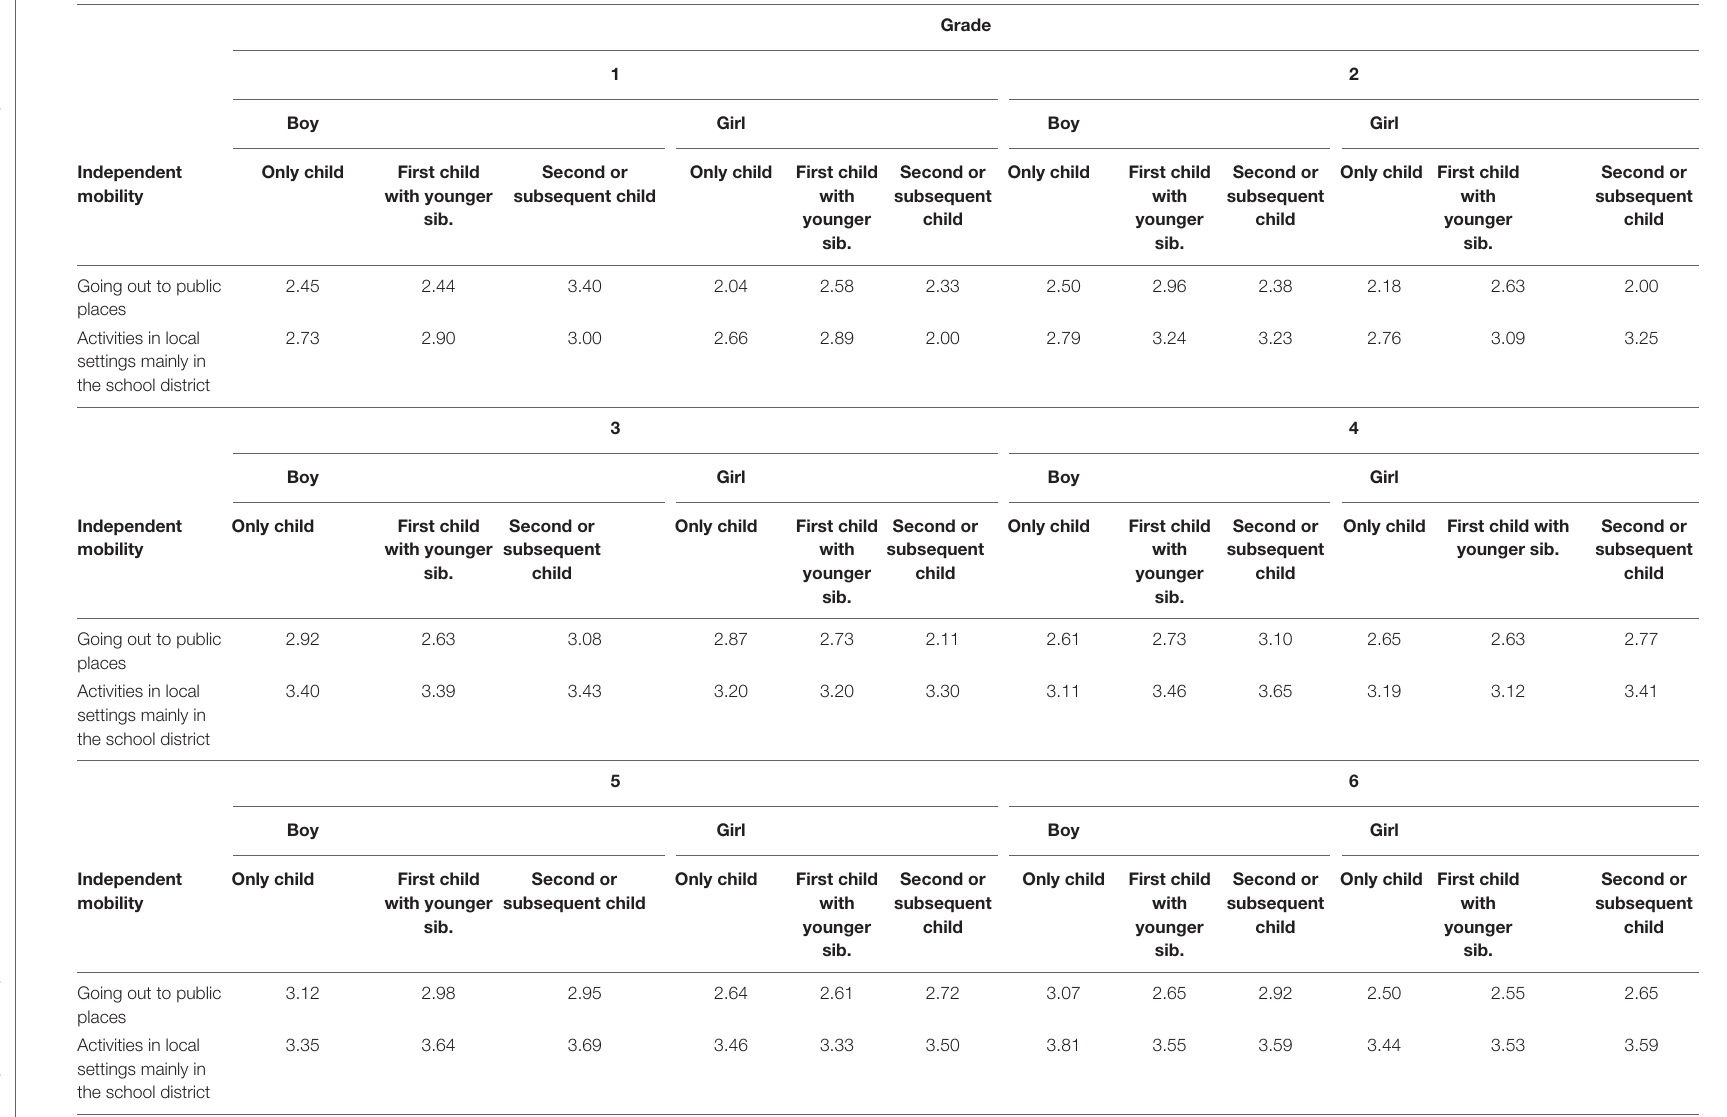
TABLE 3 | Associations of grade, gender, and birth order with independent mobility. Grade 1 2 Boy Girl Boy